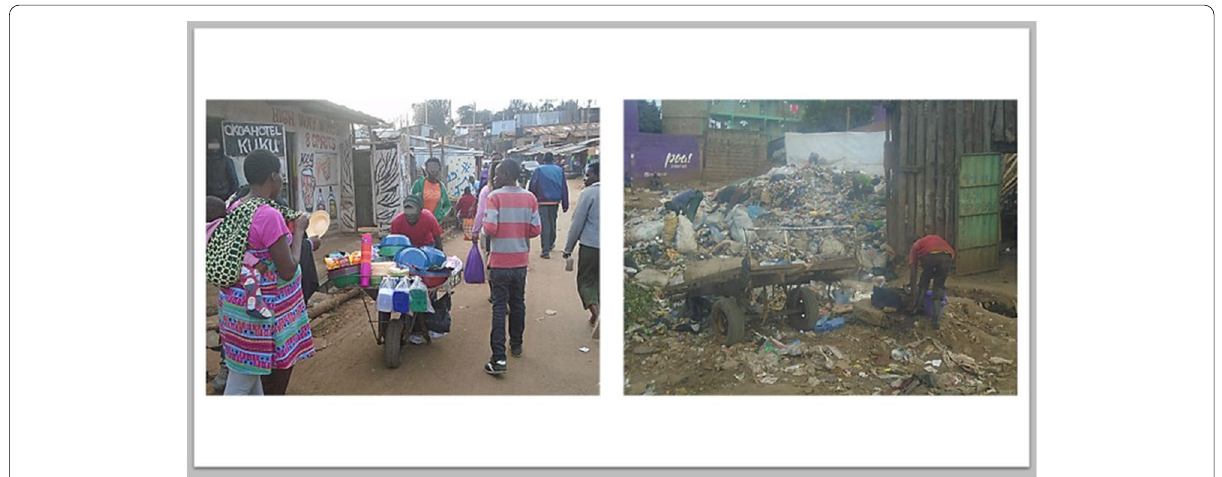
Fig. 2 Pettey trading and scavenging are some of the sources of income in the slums as demonstrated in this